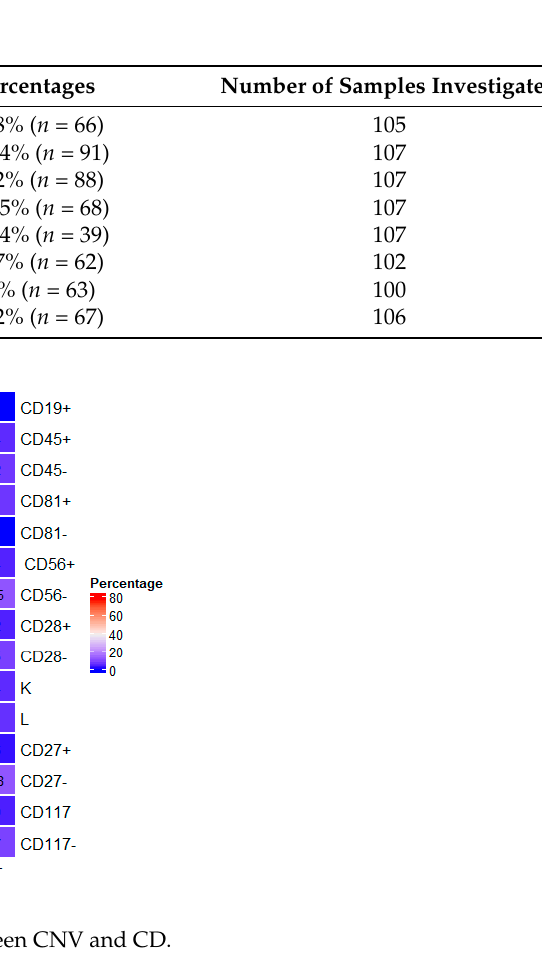
Figure A4. Heatmap of pairwise association between CNAs. The percentage was calculated from the whole group.